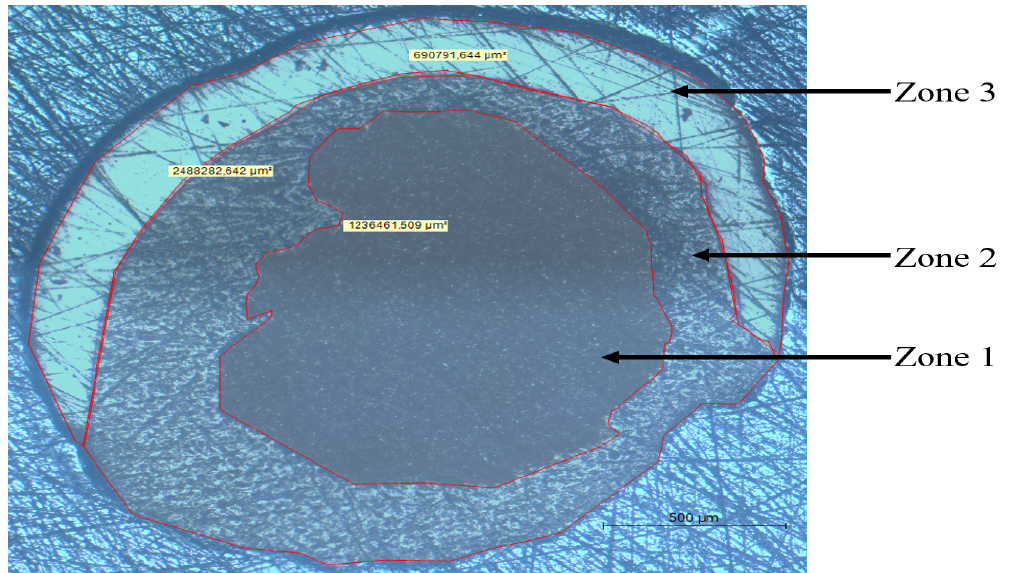
Figure 10. Schematic of the three layer zones present in samples 1 and 2.